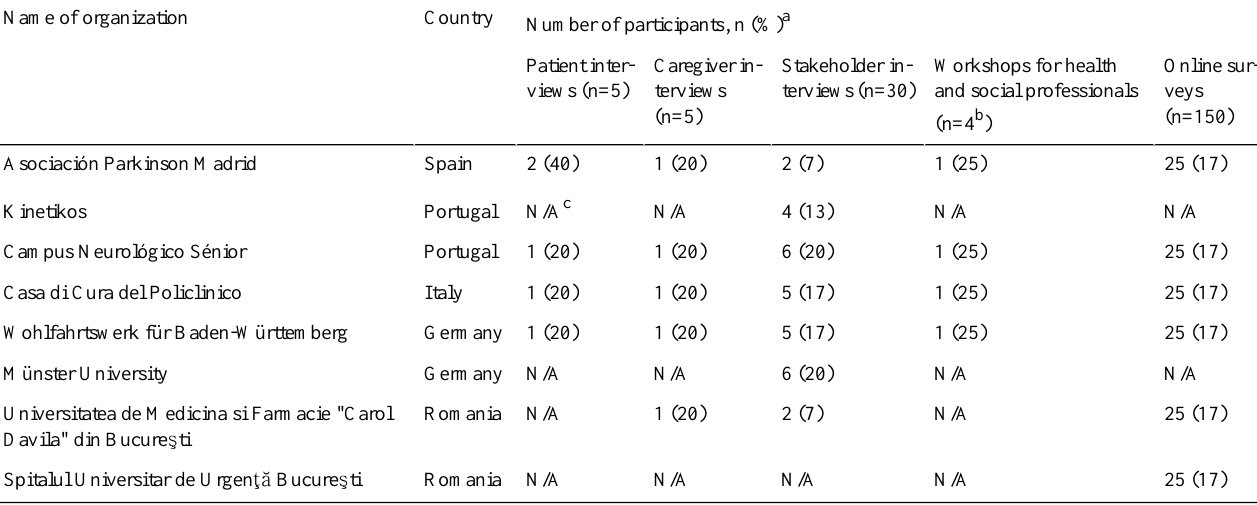
Table 1. Distribution of participants per organization for each mode of data collection.